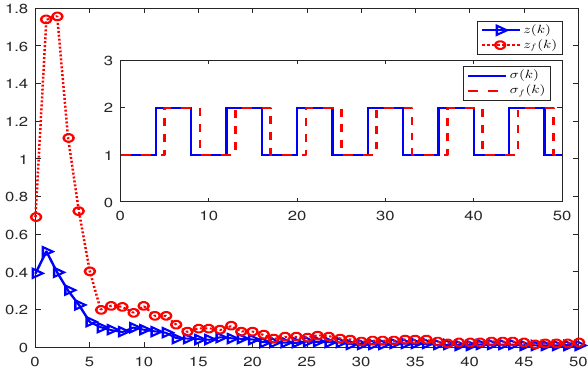
Figure 10. The simulations of z ( k ) and z f ( k ) with asynchronous switching signal.